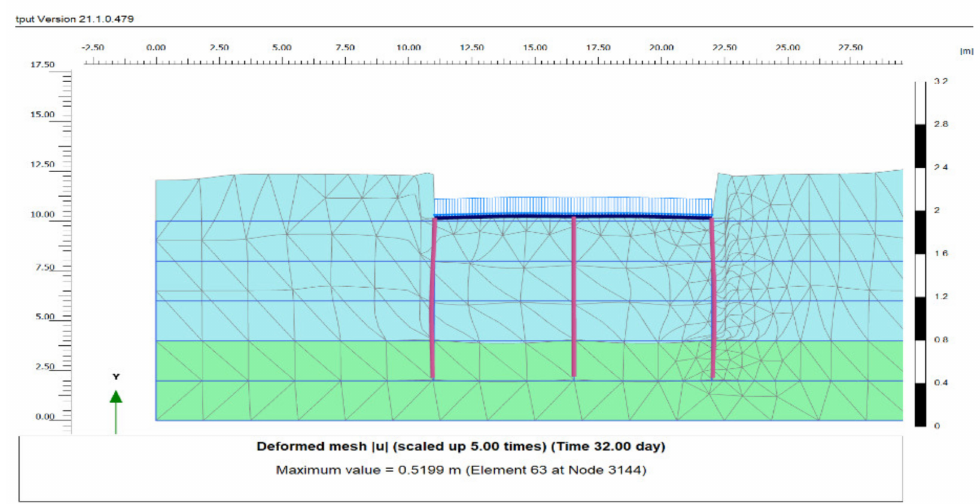
Figure 17. Piles rest at lowest layer with higher stiffness.